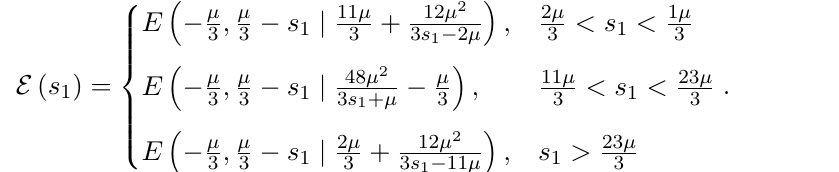
+ ( y − k ) 2 = 1 with eccentricity e 2 = 1 − B 2 A 2 B 2